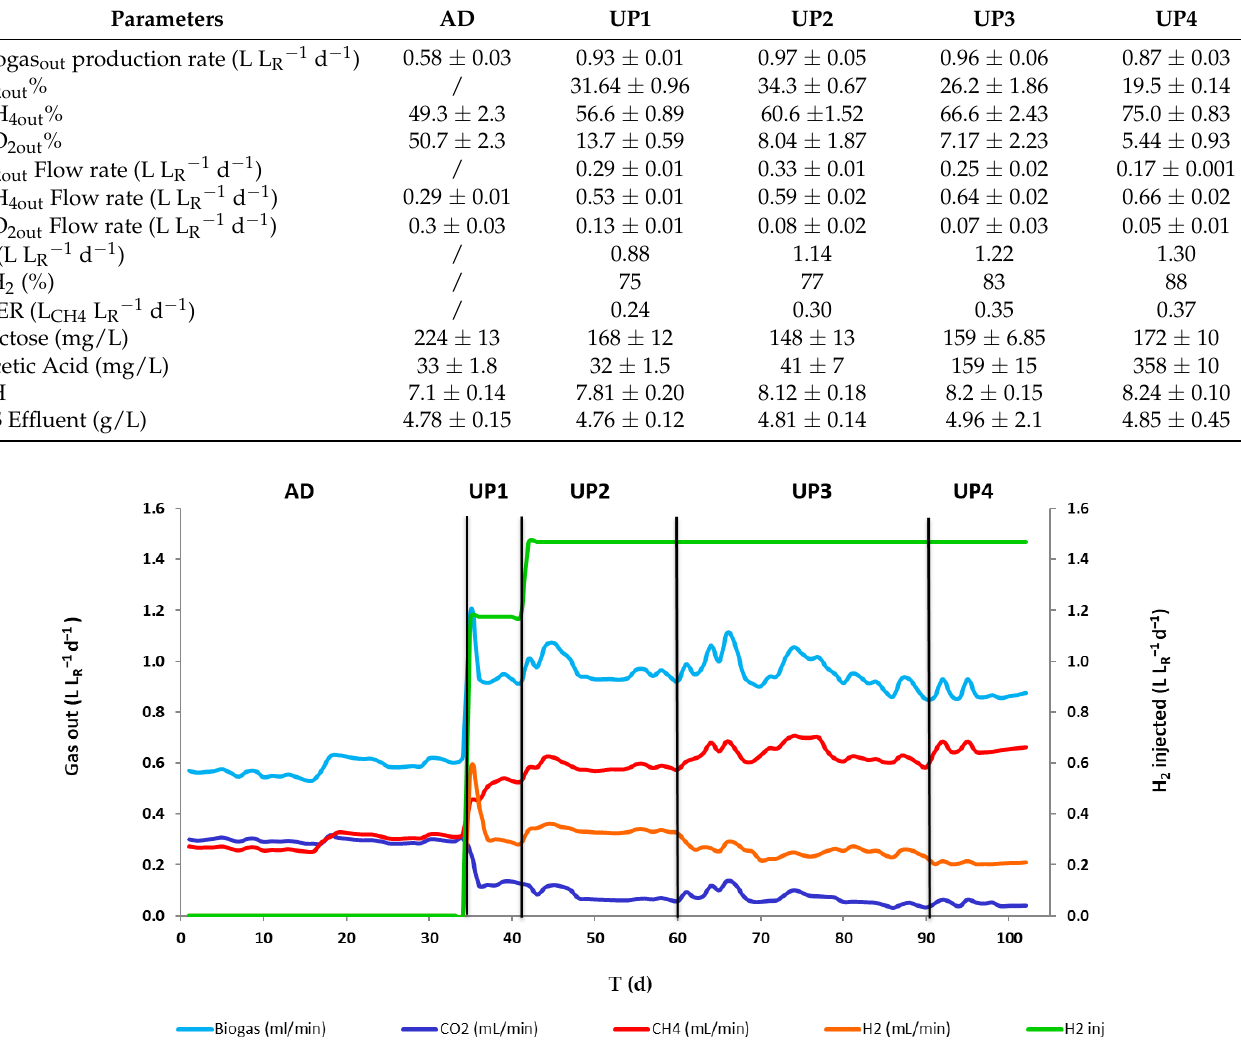
Table 3. Reactor performances at the end of upgrading (UP1, UP2, UP3, UP4) and AD phases. Parameters